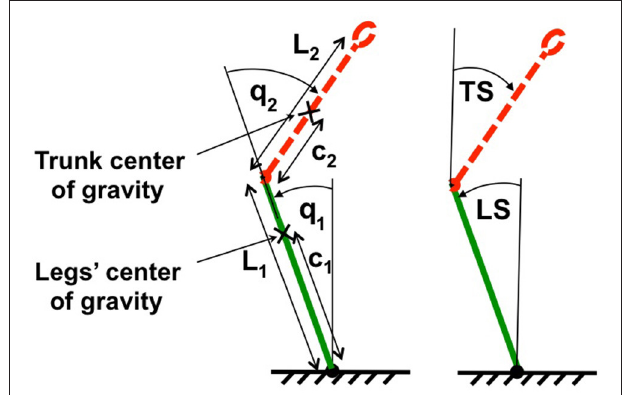
FIGURE 2 | Two-link biomechanical model of the humanoid robot. The trunk is represented by red dotted line and the legs are represented by a green solid line. L1, L2, c1, and c2 are lengths and locations of centers of mass for legs and trunk respectively. On the left body position is expressed in terms of joint coordinates (ankle and hip angles, q 1 and q 2 ), on the right in terms of space coordinates trunk in space (TS) and leg in space (LS) relative to the gravitational